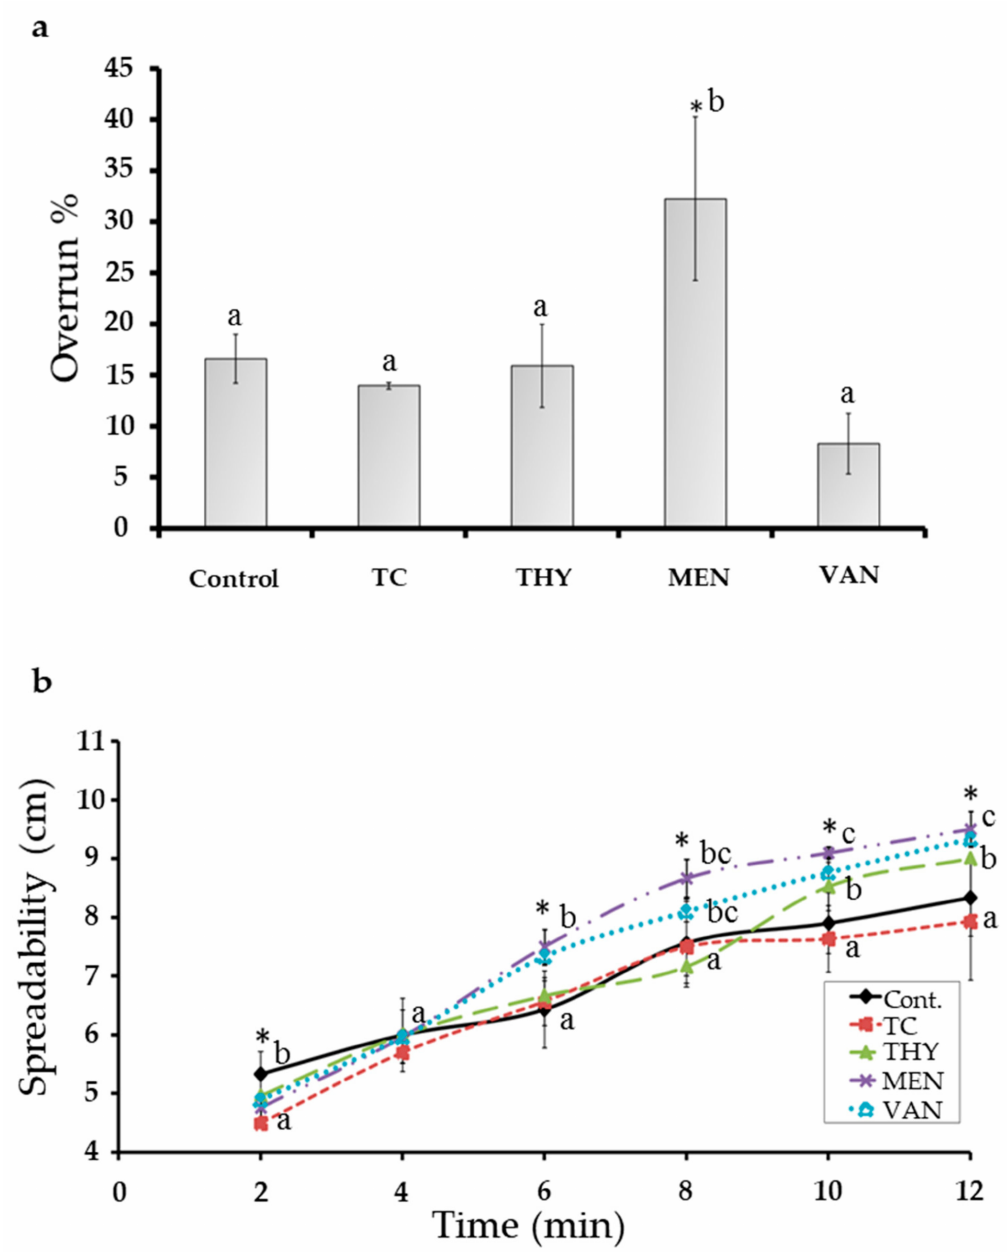
Figure 3. ( a ) Overrun % of the different mixtures of TC, THY, MEN, or VAN egg yolk ice creams; ( b ), Spreadability patterns of the different studied groups. Mean ± SD with different Roman alphabet and asterisk (*) indicate that the values differ significantly ( p -value ≤ 0.05; a < b < c) at the different columns and the same time